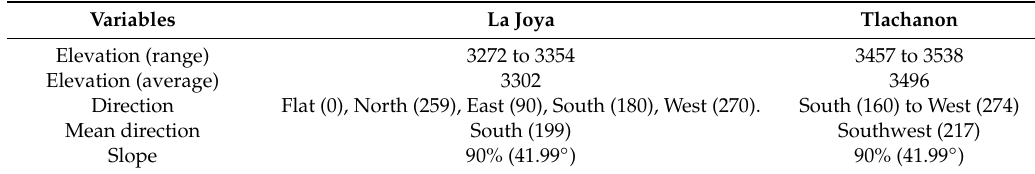
Table 5. Physiographic variables of the La Joya and Tlachanon